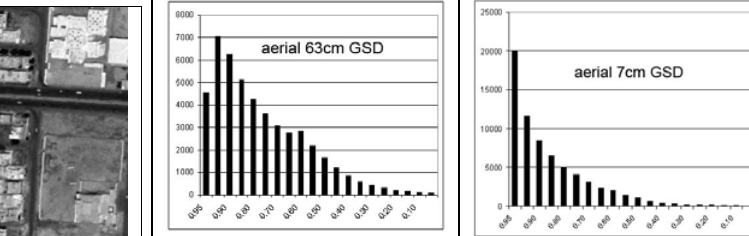
Figure 6: Points matched by LSM (white) laid over sub-image, left: aerial photo reduced to 28cm GSD, right: GeoEye-1 Similar to the aerial stereo pairs with 63cm GSD, also the satellite stereo pairs have points not matched by LSM in shadow areas, occlusions and at low contrast areas (figure